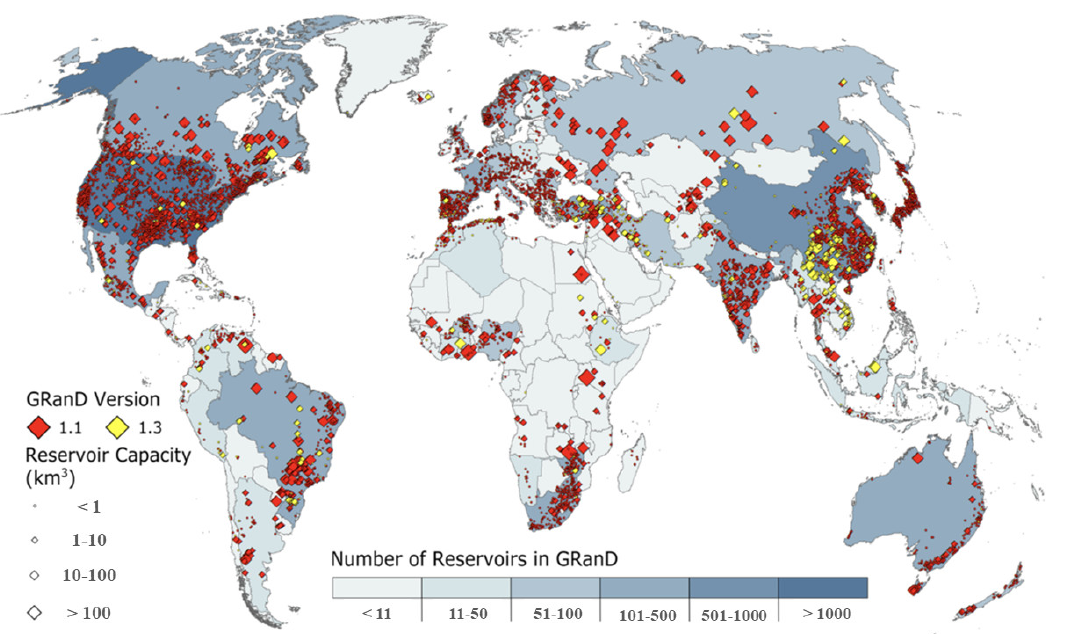
Figure 1. Number of dams constructed worldwide before 2000 (red dots) and between 2000 and 2016 (yellow dots). Source: [5].